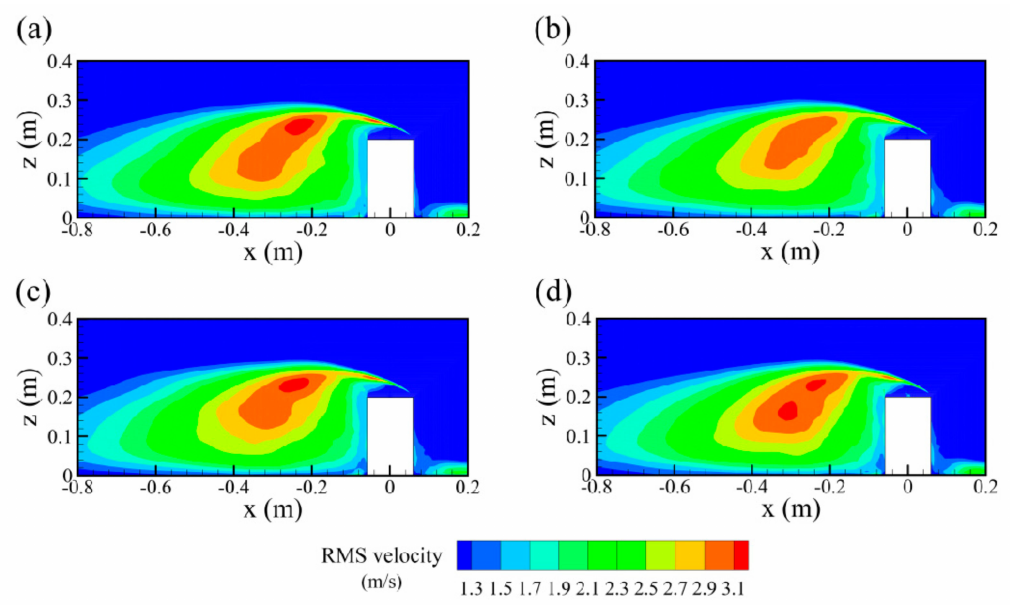
Figure 15. RMS velocity contours: ( a ) no actuation; ( b ) case A; ( c ) case B; ( d ) case